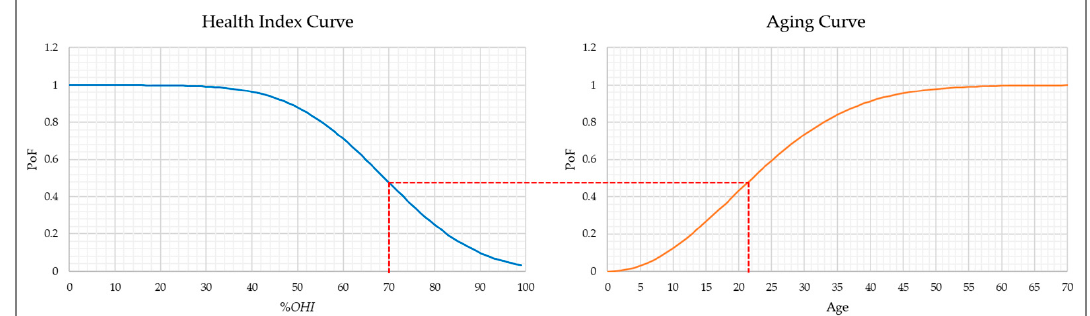
Figure 6. Estimation of apparent age of system [26].